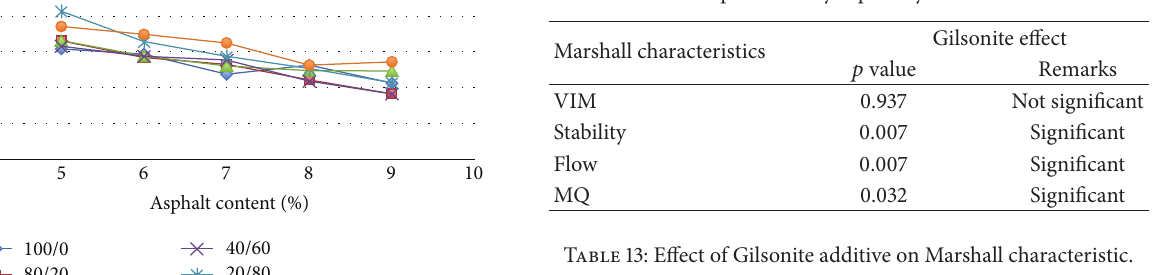
Figure 7: Marshall VMA of specimens (%) at each asphalt content and coarse aggregate proportion. Table 12: Summary of effect of Gilsonite additive on the Marshall characteristics and permeability capability.